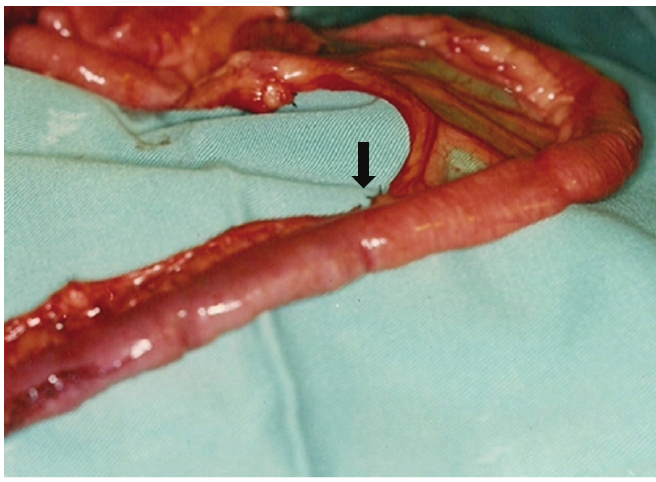
FIGuRE 1 - Preparation of the terminal ileum. Section of ileal arcade